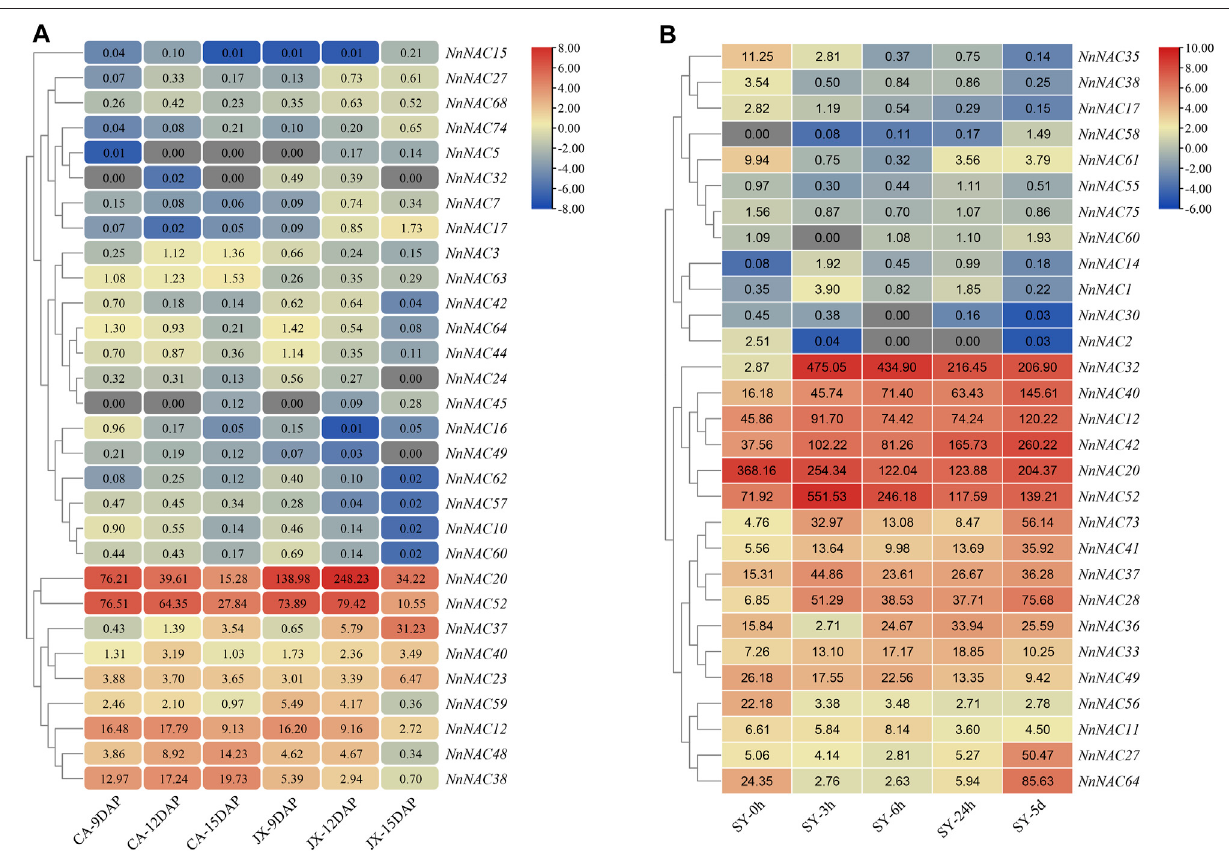
Frontiers in Genetics |